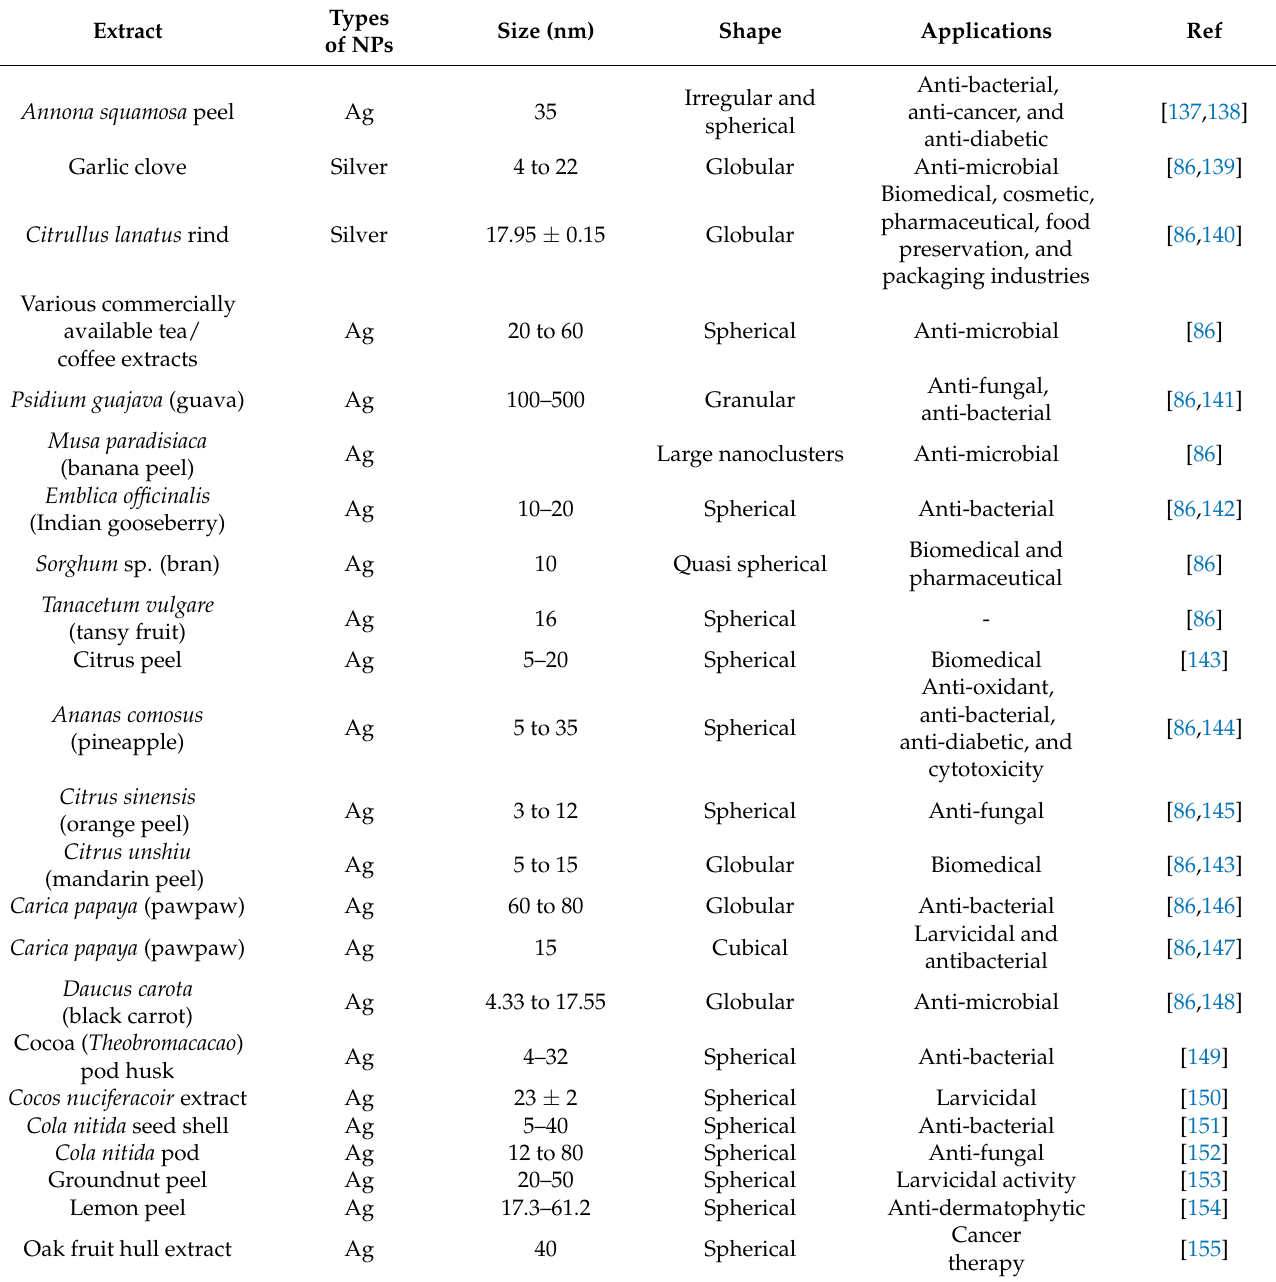
Table 2. Synthesis of NMs by